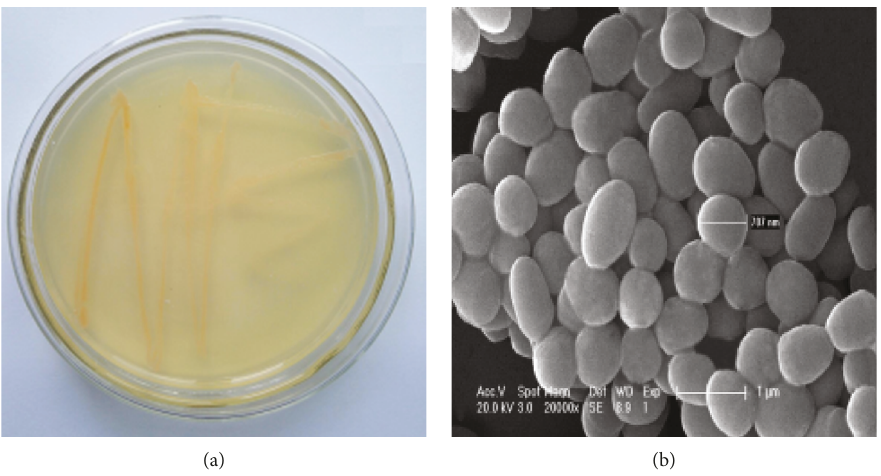
Figure 1: Rhodococcus DSSKP-R-001: (a) growth and (b) electron microscopy.